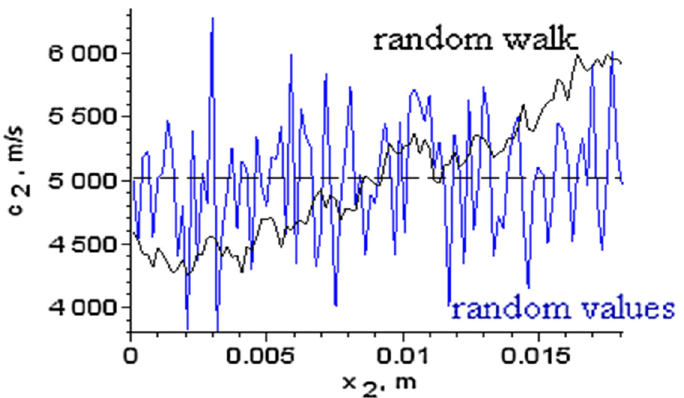
Figure 4. Random sound speeds generated for the medium of interest by two methods.